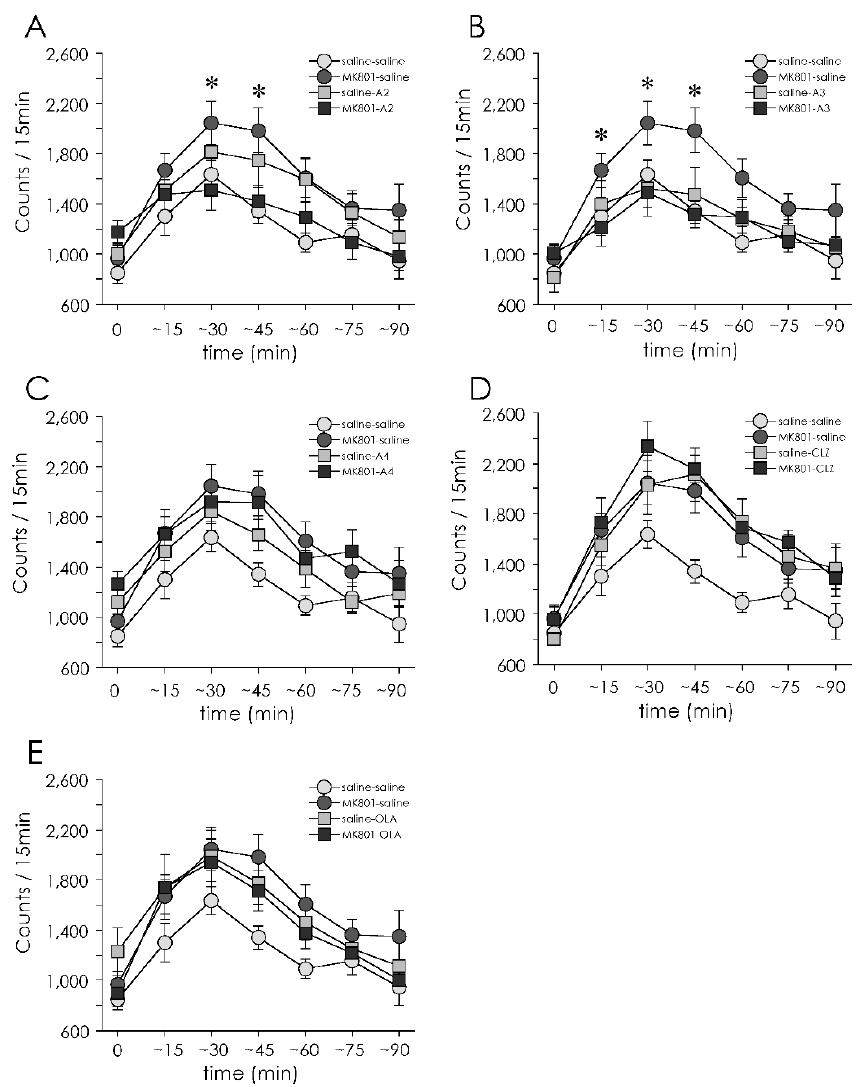
Figure 4. Effect of 14-day (PD 43–56) treatment with apocynin-tandospirone derivatives and antipsychotics on MAP-induced locomotor activity (for 90 min) on PD 57. Data with A-2 ( A ), A-3 ( B ), A-4 ( C ), CLZ ( D ) and OLA ( E ) are shown. Saline-saline group ( n = 12), MK801-saline group ( n = 12), saline-A2 group ( n = 12), MK801-A2 group ( n = 13), saline-A3 group ( n = 12), MK801-A3 group ( n = 12), saline-A4 group ( n = 13), MK801-A4 group ( n = 13), saline-CLZ group ( n = 12), MK801-CLZ group ( n = 12), saline-OLA group ( n = 12), and MK801-OLA group ( n = 12). Values are expressed as means ± SEM. * p < 0.05 compared MK-801- A-2 or A-3 with MK-801-saline